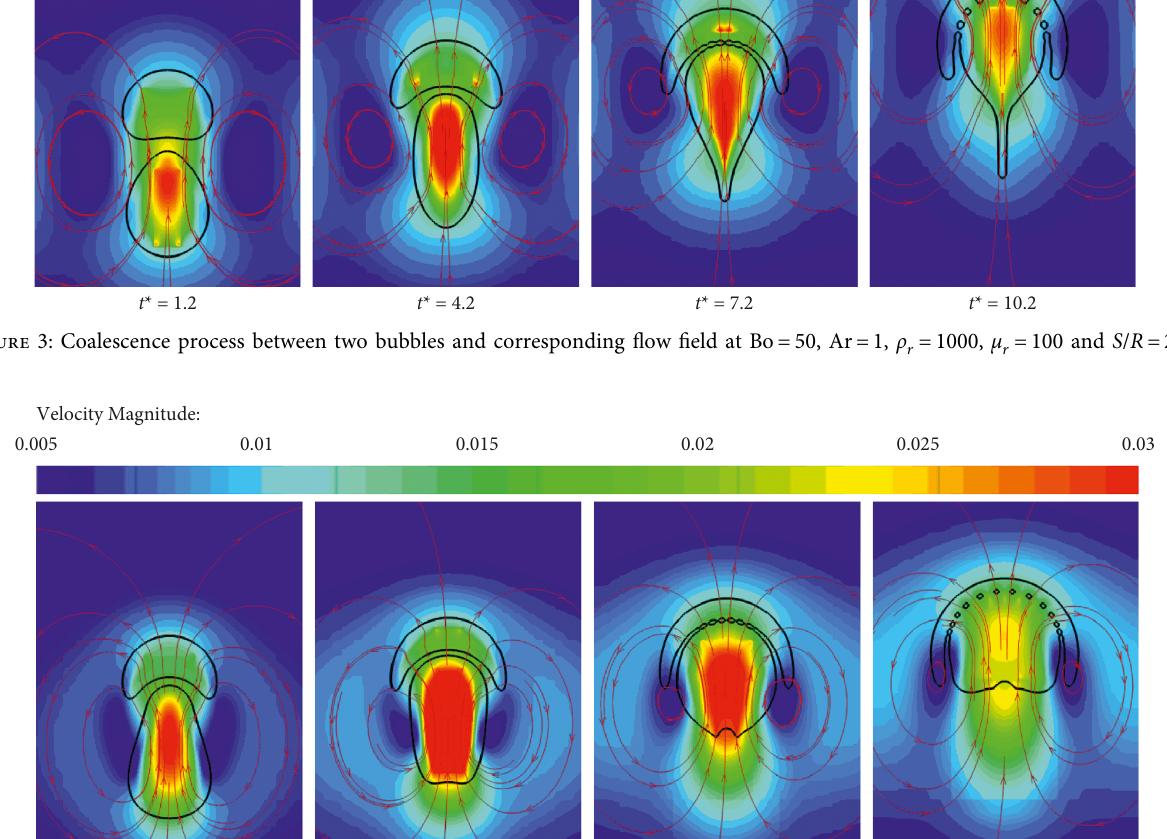
� 1000, μ � 100 and S / R � r r